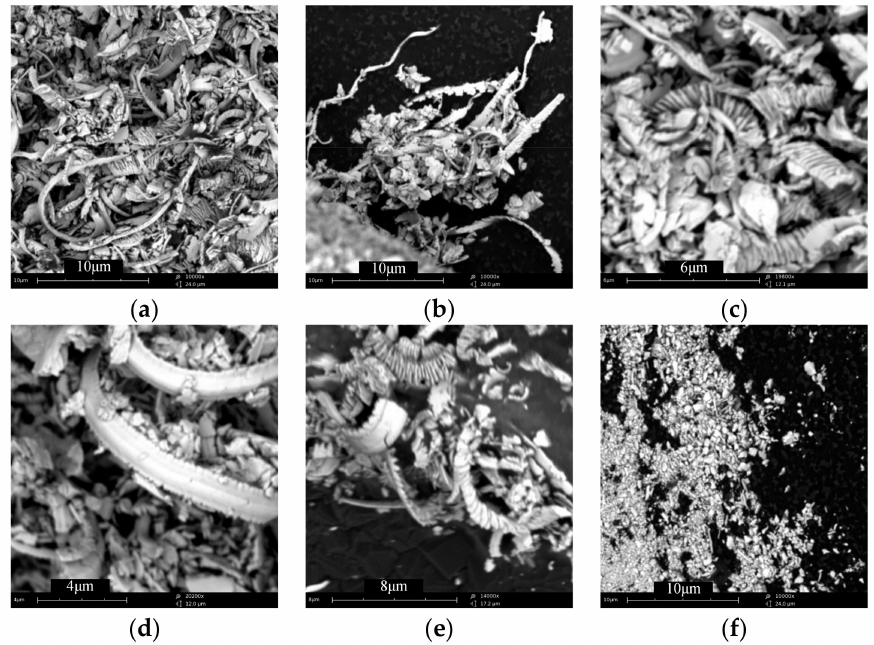
Figure 17. SEM images of chips: ( a , b ) long and continuous chips; ( c – e ) ductile chip with smooth back surface; ( f ) short and fractured